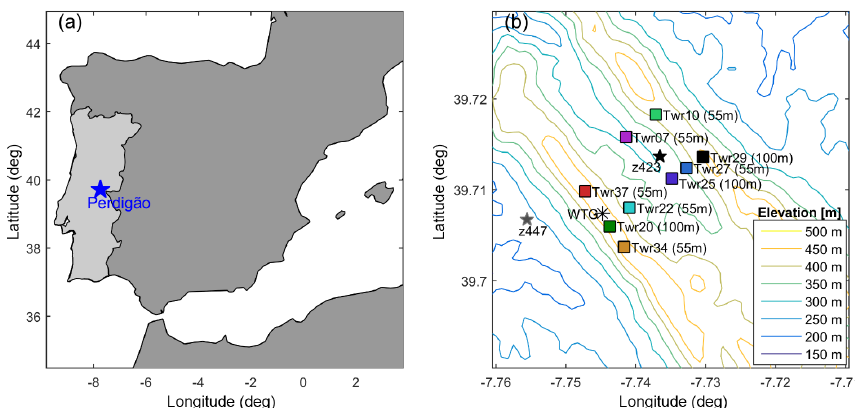
Figure 1. (a) Location of the Perdigão measurement site in Portugal. (b) Overview of the tower and ZephIR lidar locations and site topog- raphy (measured by the Shuttle Radar Topography Mission; Farr et al., 2007). The height of each tower is shown in parentheses. The nine colors shown in this figure are used to distinguish the nine towers throughout the paper. A single wind turbine is located on the SW ridge (denoted by WTG ∗